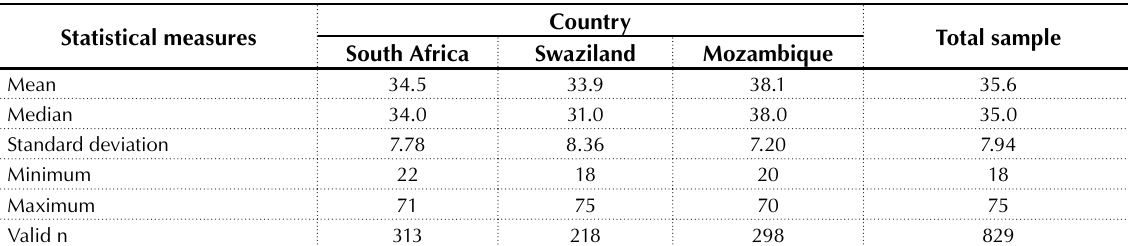
Table 3. Descriptive statistics for age by